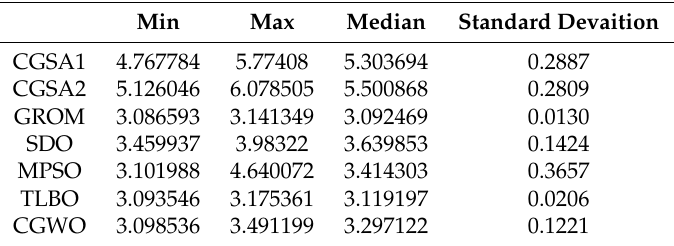
Table 10. Statistical analysis for case 1.